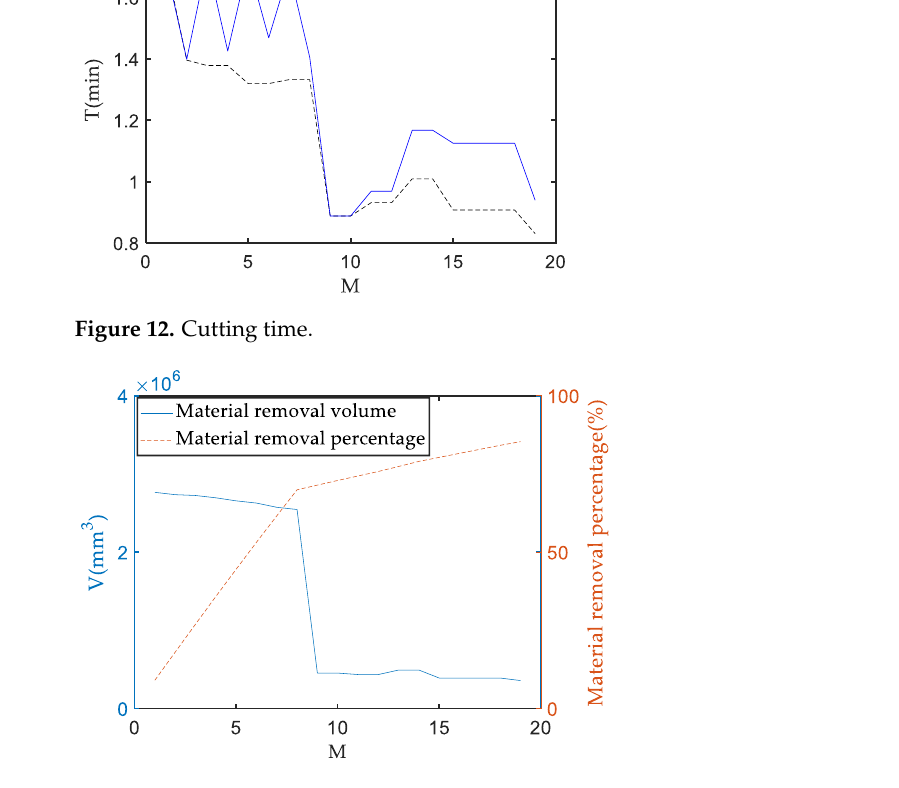
Figure 13. MRV and MRP.